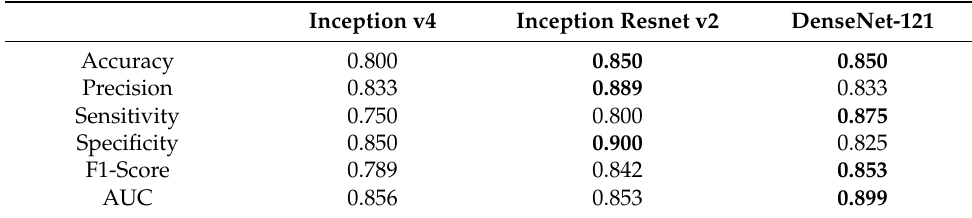
Table 2. The quantitative results of using different convolutional neural networks (CNNs).